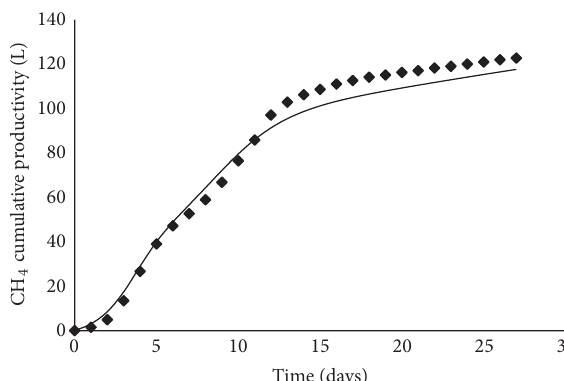
Figure 7: Comparison between experimental data (belonging to validation dataset) and methane cumulative productivity as pre- dicted by the ANN 2 . Operating conditions: run 3 of Table 2.